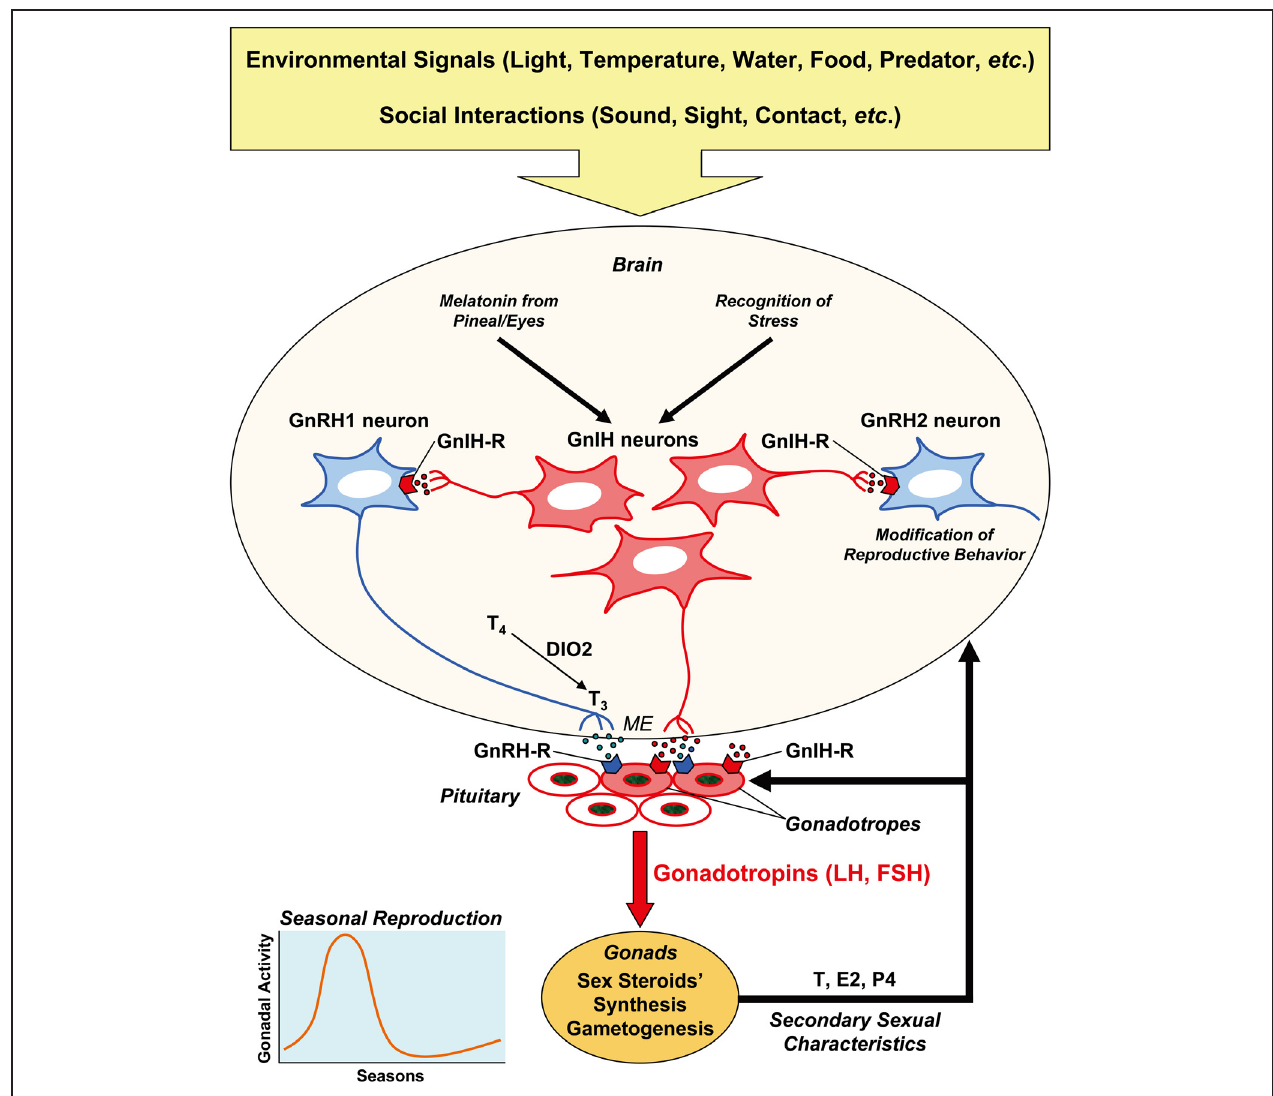
FIGURE 1 | Schematic model of the mechanism of seasonal reproduction in birds. Seasonal breeding birds detect environmental signals, such as light, temperature, water, and food availability, predator pressure, etc. to time reproduction. Their reproductive activity is also shaped by social interactions with the conspecifics, in terms of sound, sight, contact, etc. Hypothalamic neurons in the bran integrate external and internal signals, and regulate reproduction by releasing neurohormones at the median eminence (ME) to regulate the pituitary hormone secretion. The anterior pituitary gland synthesizes and releases gonadotropins (LH, FSH), and gonadotropins act on the gonads to stimulate gametogenesis and sex steroid secretion. Sex steroids induce secondary sexual characteristics of the organism. A hypothalamic neuropeptide, GnRH1, activates reproduction by stimulating gonadotropin synthesis and release via its receptor (GnRH-R) expressed on